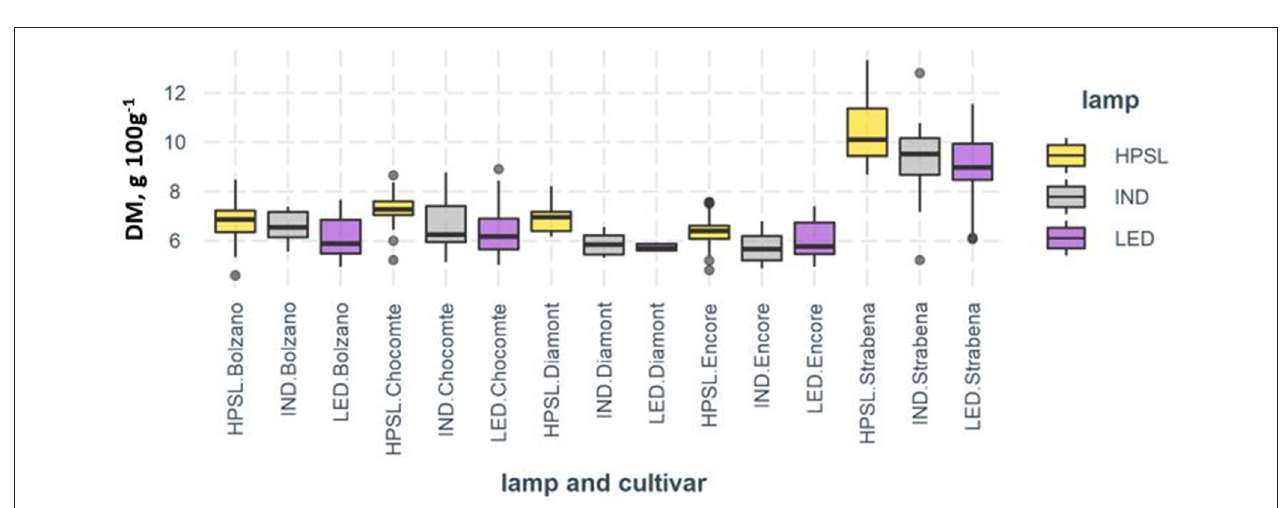
FIGURE 4 | Fresh weight (g) of tomato fruits grown under different supplemental light sources.